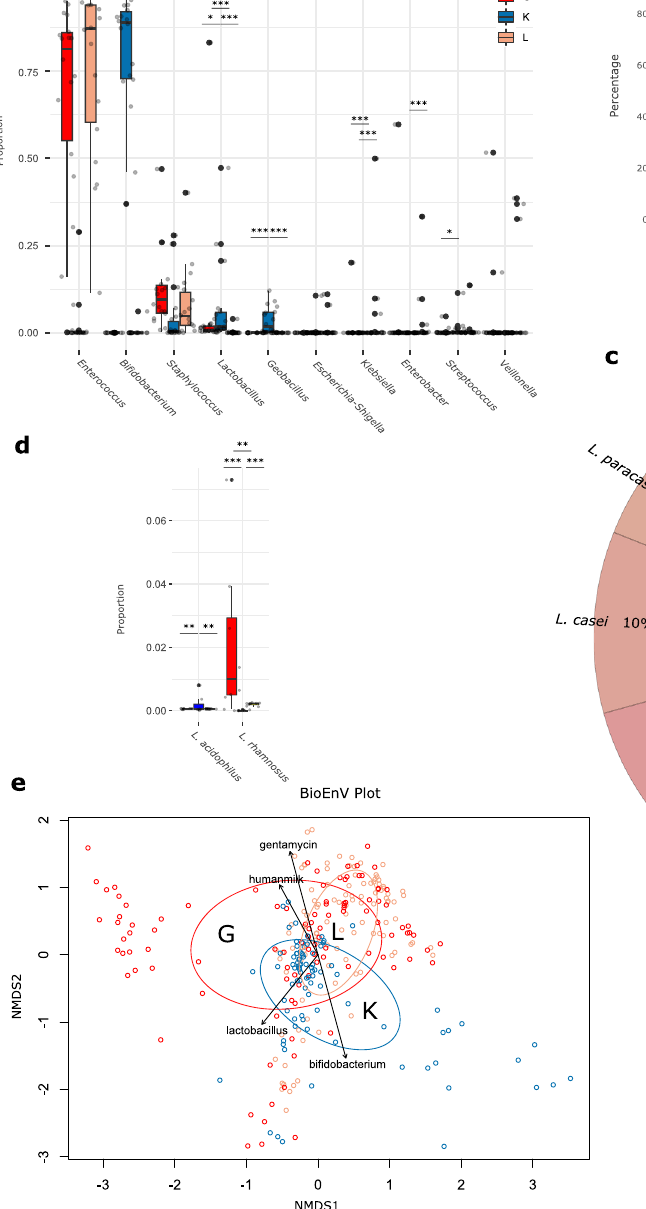
independent samples, DSeq2) Lactobacillus acidophilus : K:G q =0.003, K:L q =0.002, G:L q =1; Lactobacillus rhamnosus : K:G q <0.001, K:L q =0.001, G:L q =0.001 (i) L. acidophilus NCDO 1748 and (ii) L. rhamnosus LCR 35. e Biplot of BioEnv with correlations of the Euclidean distances for the metadata of dissim- ilarities between the centers (administration of gentamicin, of probiotic Lactoba- cillus or Bi fi dobacterium and human milk), amplicon data. G in red, K in blue, L in green;signi fi cancelevelsareindicatedwithasterisksfor q <0.001(***), q <0.01(**), q <0.05 (*) for differentially abundance testing by DSeq2, adjusted for multiple comparisons. Centers are abbreviated by G (Graz), L (Leoben), and K (Klagenfurt). Forboxplots,theupper,middleandlowerhorizontallinesoftheboxrepresentthe upper, median, and lower quartile; their whiskers depict the smallest or largest values within 1.5-fold of the interquartile range. Source data are provided as a Source Data fi le (see Github